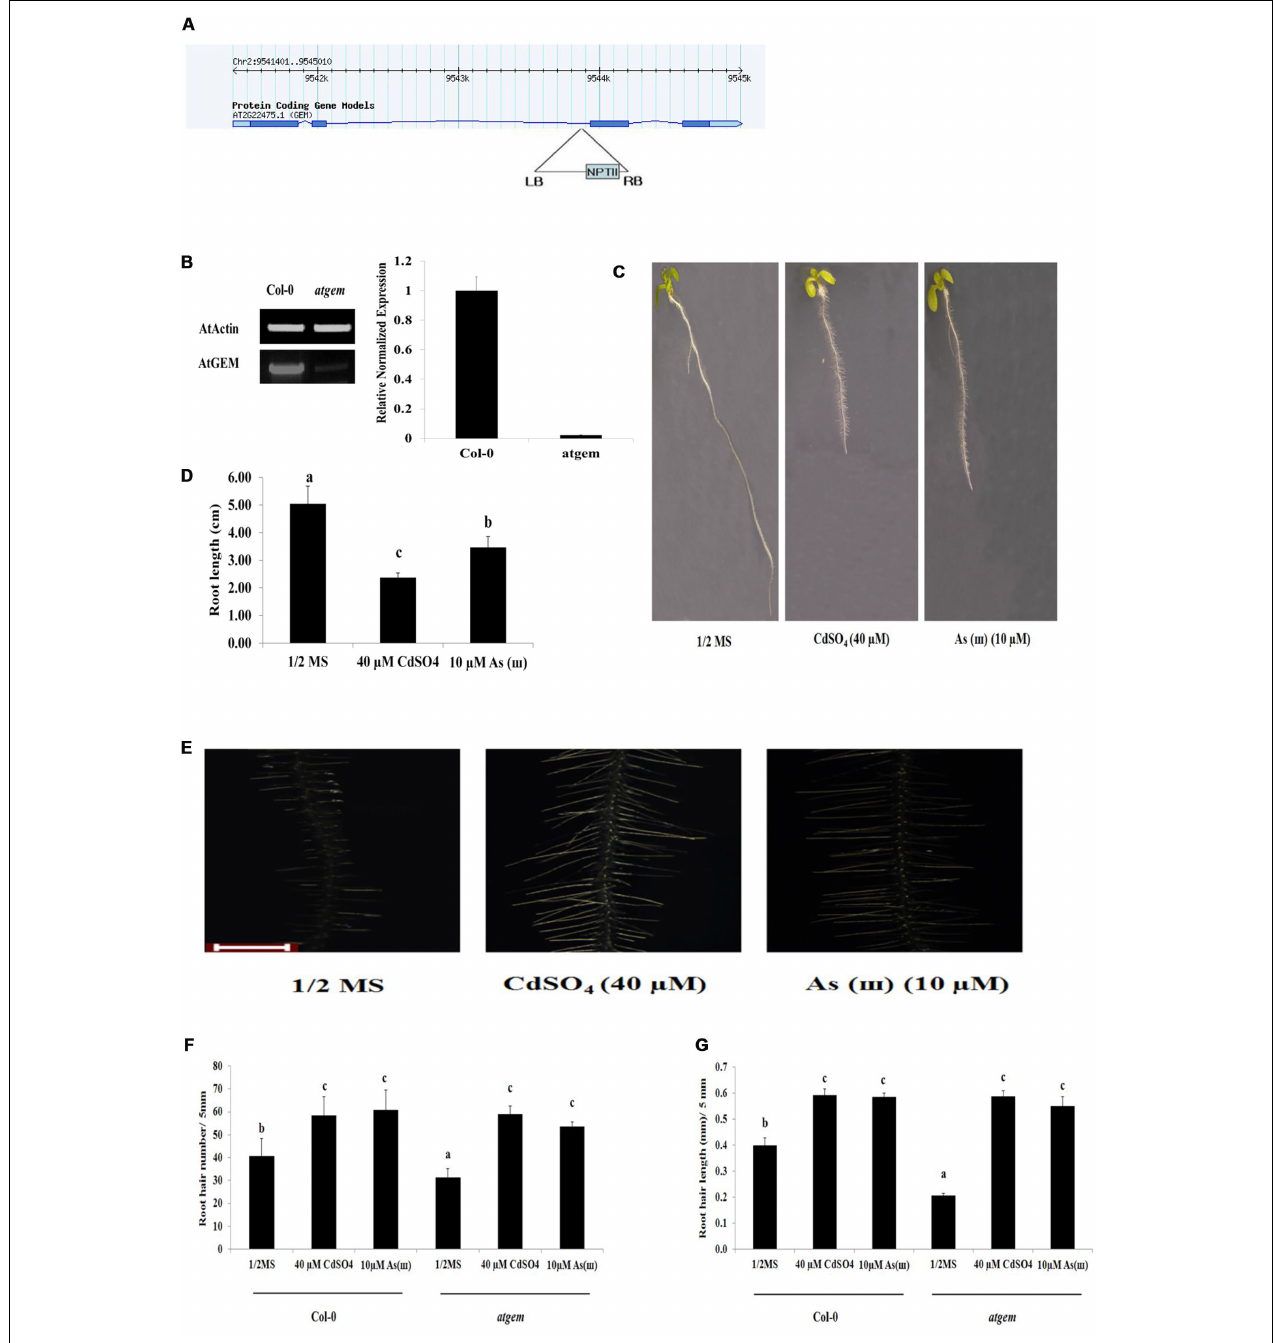
FIGURE 7 | Root hair length and density in response to Cd and As(III) in gem Arabidopsis . (A) Diagram showing T-DNA insertion position in gem Arabidopsis . (B) Right, transcript levels (semi-quantitative RT-PCR) of AtGEM in control ( Col -0) and gem Arabidopsis . A PCR product of actin ( AtActin ) was used as a loading control; Right, real-time PCR result. (C) Morphology of gem Arabidopsis (1-week-old) seedlings germinated and grown on 1/2 MS agar plates containing no metal (left), 40 µ M CdSO 4 (center), and 10 µ M AsNaO 2 (right). (D) Quantification of root length of gem Arabidopsis shown in (C) . (E) Root hair morphology of gem Arabidopsis germinated and grown on 1/2 MS with no metal (left), 40 µ M CdSO 4 (center), and 10 µ M As(III) (right). Roots were observed at 40 × magnification; scale bars = 0.2 mm. (F) Graphs representing root hair density in a 5 mm section from the starting point of differentiation zone in gem Arabidopsis root shown in (E) . (G) Graphs representing root hair length in a 5 mm section from the starting point of differentiation zone in gem Arabidopsis root shown in (E) . Values are average ( ± SE) of three-independent experiments, each involving 10 seedlings. Different letters in each column indicate a significant difference according to Tukey’s multiple comparison test ( p ≤